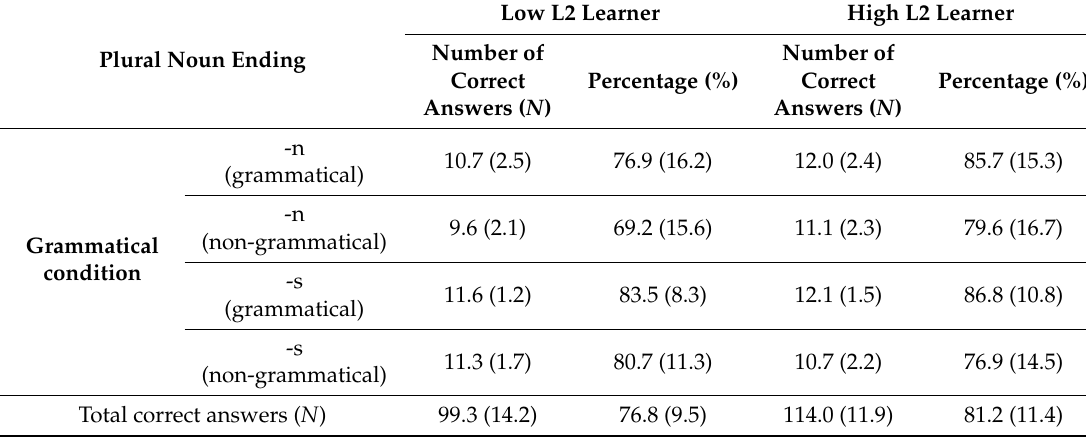
Table 3. Total number and percentage of correct answers for plural noun ending by learning